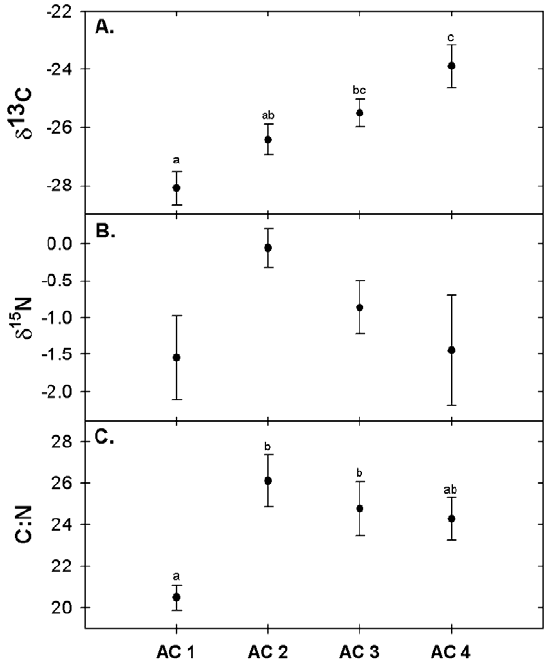
Figure 5. Relationship between green ash foliar 13C and ash canopy decline ( A ), foliar 15N ( B ), and foliar carbon to nitrogen ratio ( C ). Significance levels depict results of Tukeys HSD pairwise comparisons ( p < 0.05).